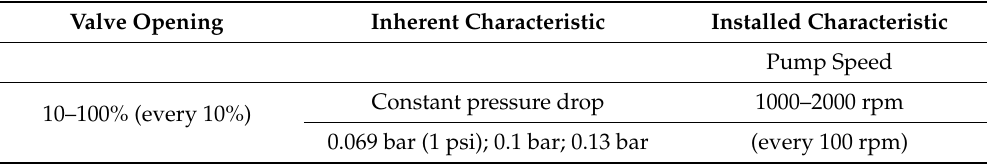
Table 3. Experimental conditions for measurement of flow coe ffi cients.